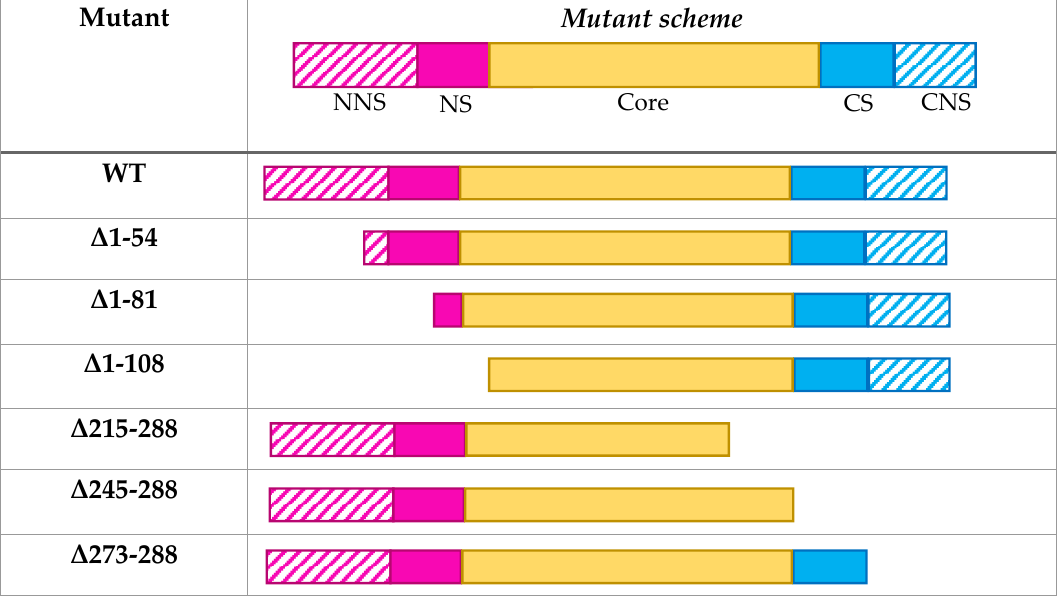
Figure 2. Design of coat protein truncated versions. NNS: CP N-terminal non-solved region (aa 1–65). NS: CP N-terminal-solved region (aa 66–97). CS: CP C-terminal-solved region (aa 245–272). CNS: CP C-terminal non-solved region (aa 273–288). Each of these domains is represented with di ff erent colors: NNS (striped pink), NS (solid pink), CS (solid blue), and CNS (striped